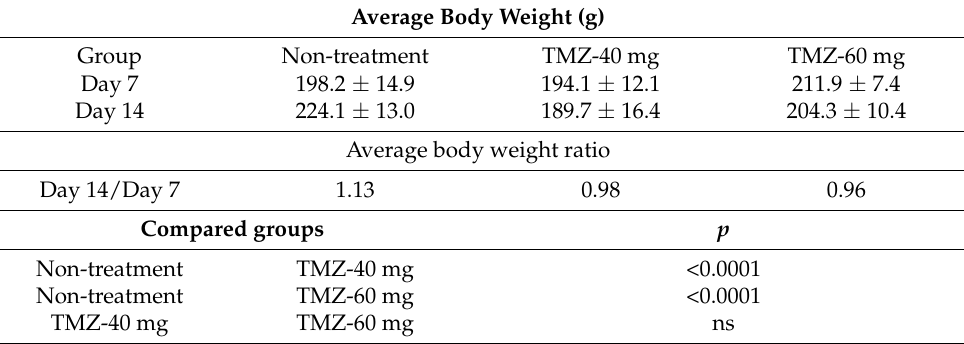
Table 1. Weight changes due to side effects of TMZ treatment. Values are expressed as means ± standard deviations (SDs). ns: not